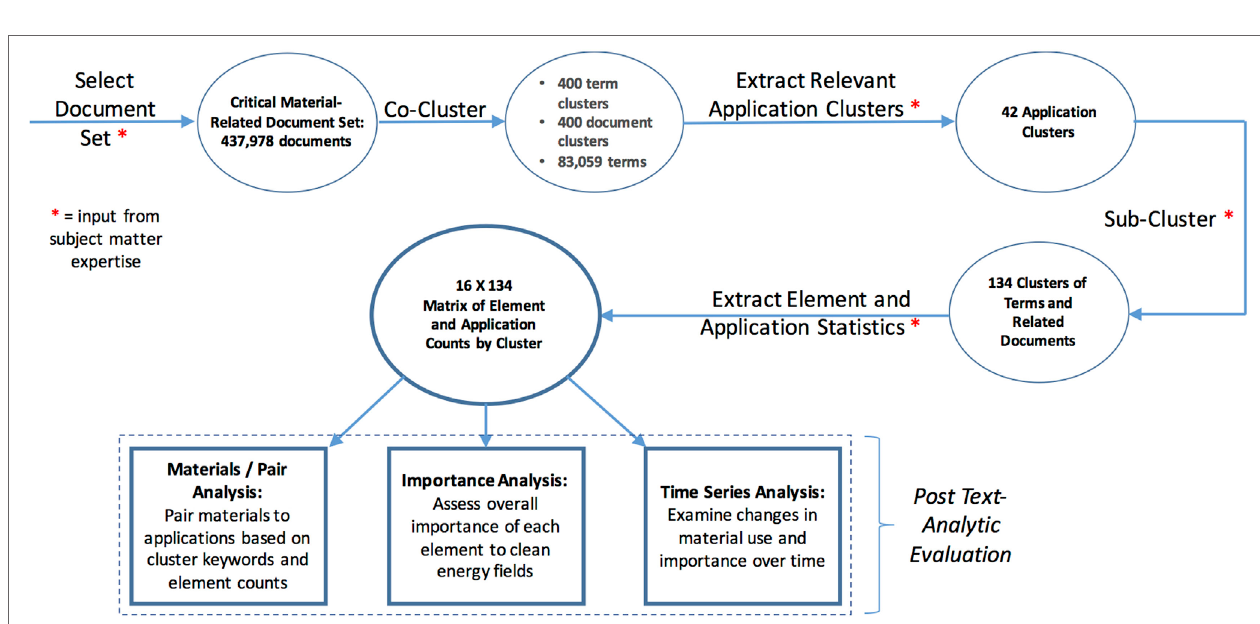
FigUre 1 | 2011 Critical Materials Importance Analysis matrix, published by experts at the Department of Energy. This matrix served as ground truth for validation.